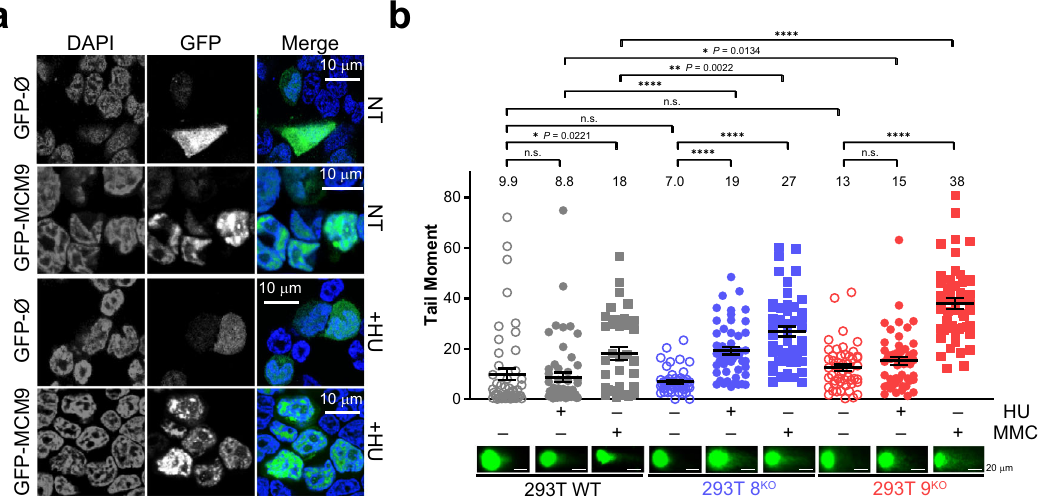
Fig.2|MCM8/9protectforksfromreplication-inducedDNAbreaks.a 293Tcells were transfected with GFP-MCM9 fusion construct or GFP alone (Ø), nontreated (NT) or treated with 2mM HU for 4h (+HU) and imaged by confocal microscopy ( n =2independentexperiments).Scalebarsrepresent10 µ m.Largerrepresentative views of microscopy images of cells are shown in Supplementary Fig. 6. b Quanti- fi cation of the tail moment (>50 cells for each condition) in a neutral comet assay